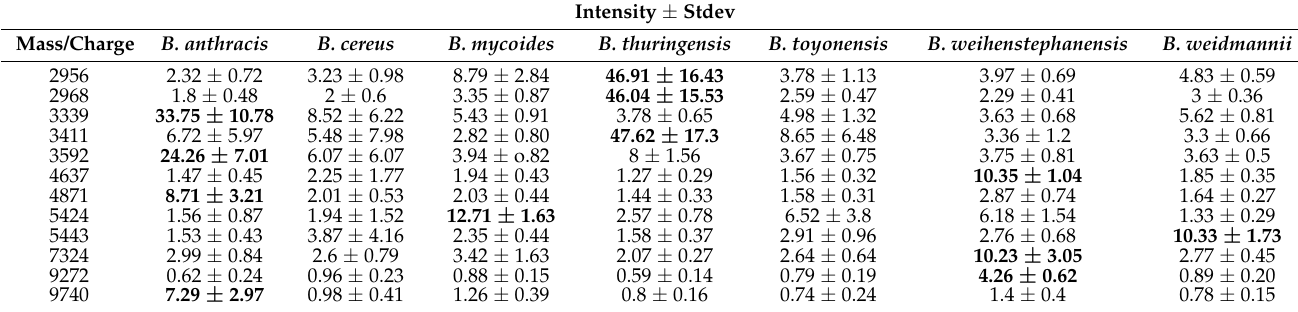
Table 1. List of the 12 ion peaks considered with their mass to charge ratio and the peak intensity average for each class and relative standard deviation. In bold are shown the higher intensities values for each mass peak, to be considered as characteristic ion peak for the class/species.